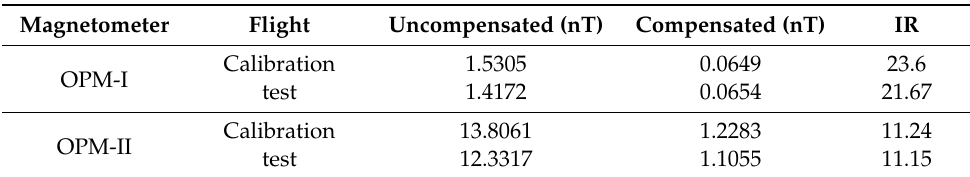
Table 3. Standard deviation and IR of different OPMs.